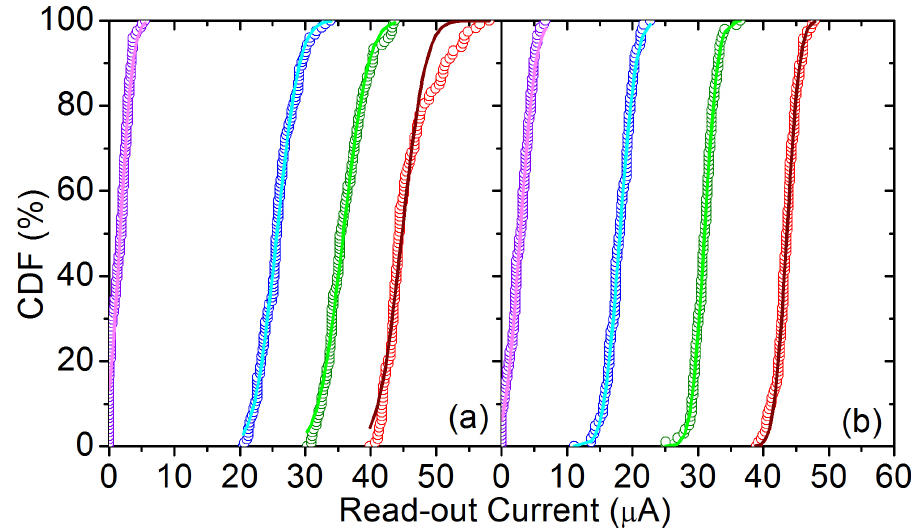
Figure 5. CDFs of the read-out currents measured at the end of the M-ISPVA (open symbols) and calculated using Gaussian distributions (solid lines) for the four conductive levels for the non- optimized ( a ) and the optimized ( b ) programming